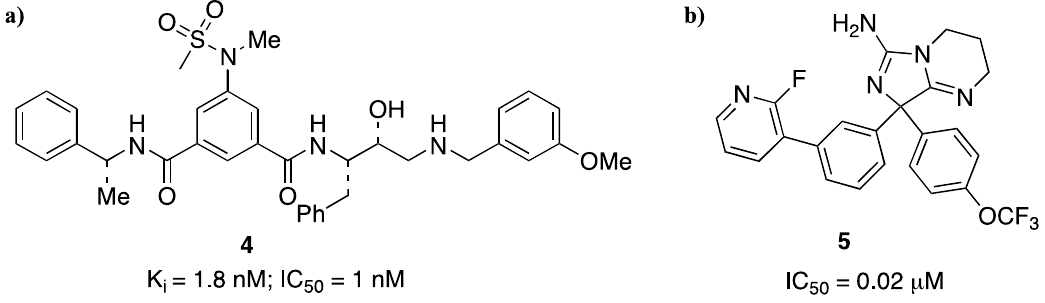
Figure 5. Two potential β -secretase inhibitors. ( a ) GRL-8234; ( b )